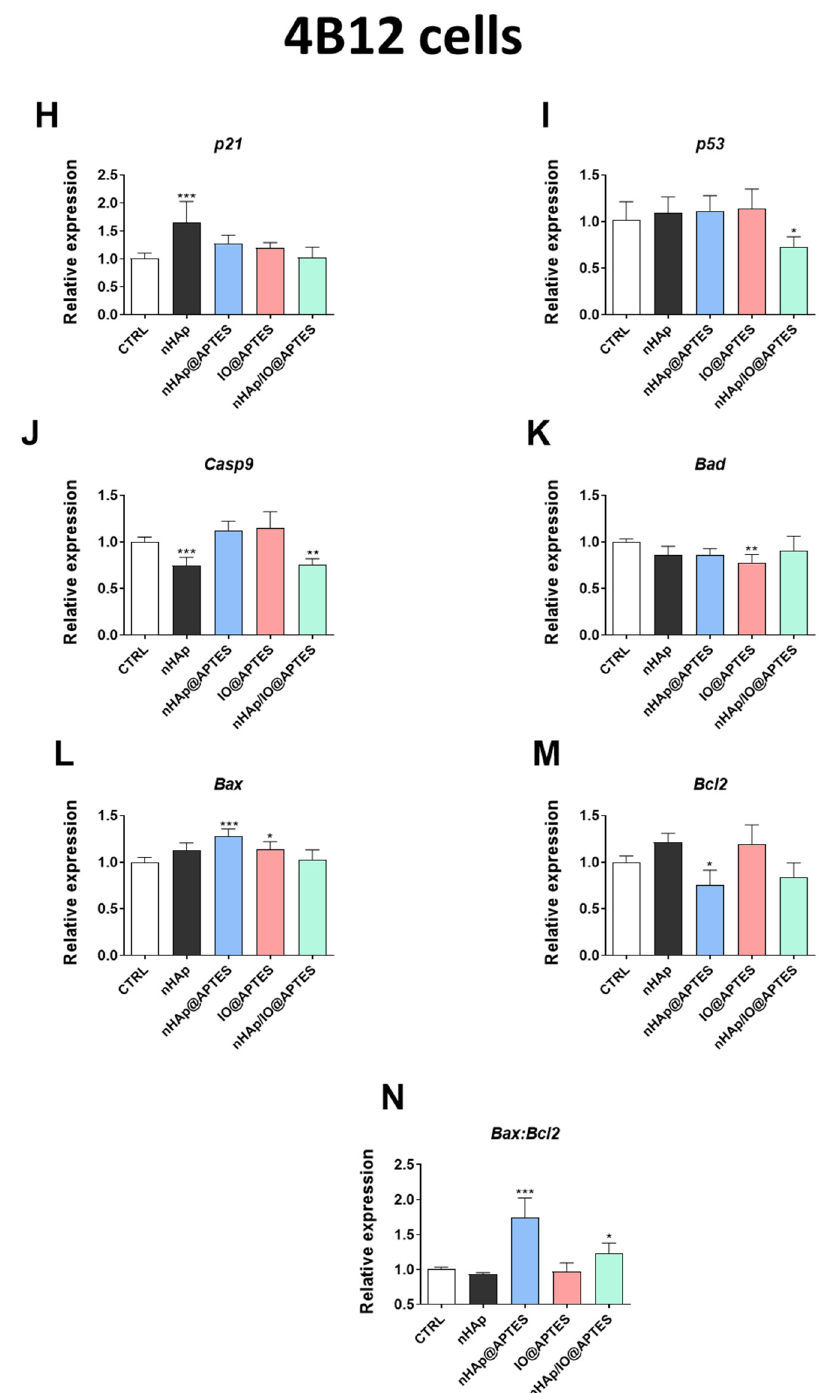
Figure 6. Evaluation of apoptosis. The impact of the biomaterials on the expression of genes associated with apoptosis: p21 ( A ), p53 ( B ), Casp9 ( C ), Bad ( D ) Bax ( E ), Bcl-2 ( F ) and Bax/Bcl-2 ratio ( G ) after 20 h of incubation of MC3T3-E1 cell line. The impact of the biomaterials on the expression of genes associated with apoptosis: p21 ( H ), p53 ( I ), Casp9 ( J ), Bad ( K ) Bax ( L ), Bcl-2 ( M ) and Bax/Bcl-2 ratio ( N ) after 20 h of incubation of MC3T3-E1 cell line. The graphs represent mean values ± standard deviation. Significant differences are indicated as follows: (* p < 0.05, ** p < 0.01 and *** p < 0.001).